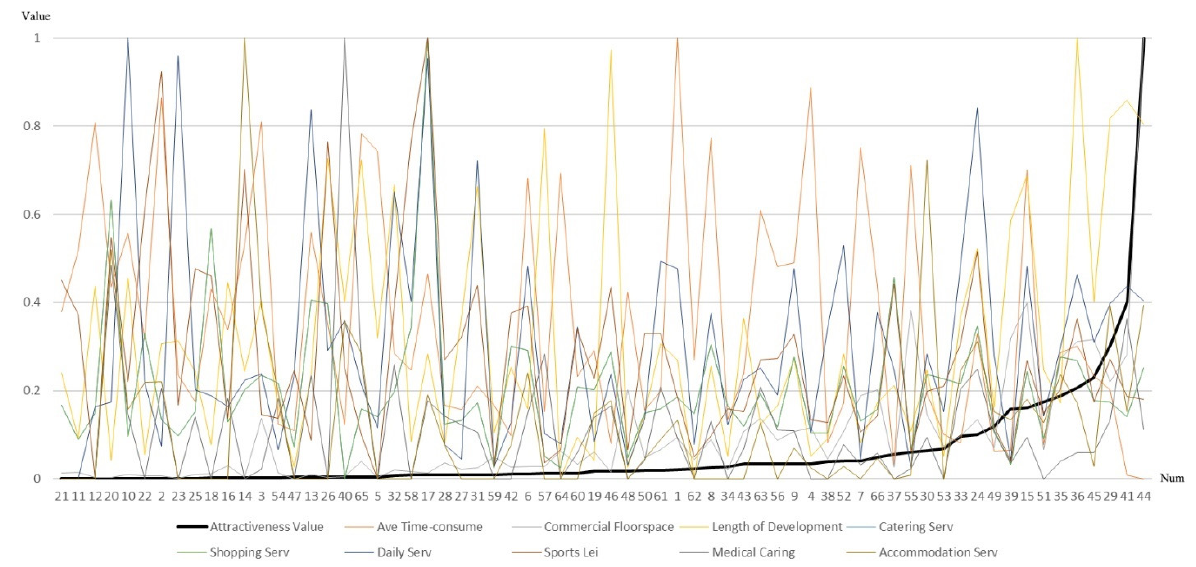
Figure 7. Line chart about the relationship between attractiveness and various variables.